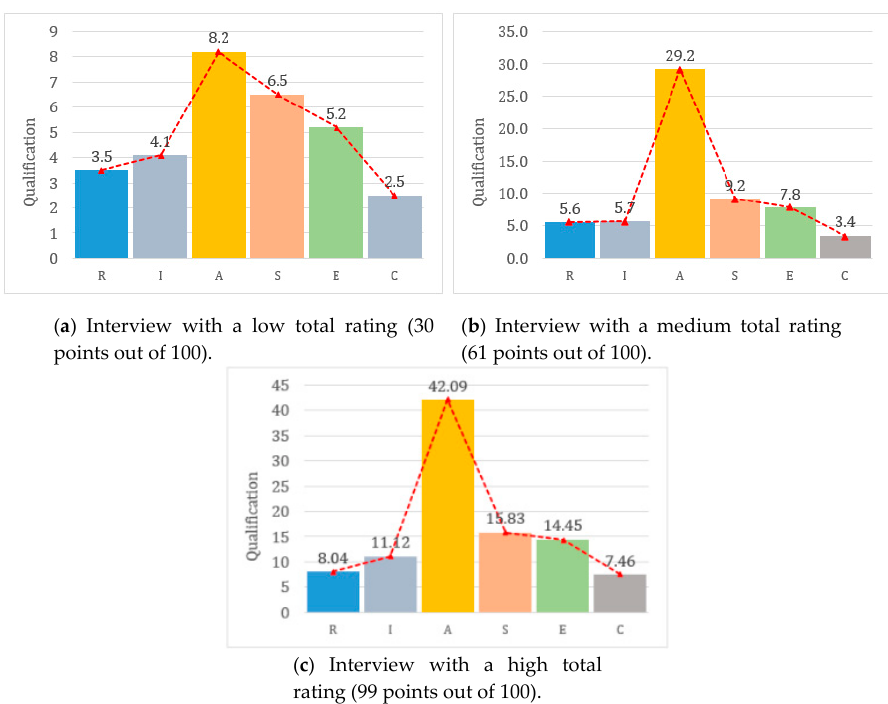
Figure 20. Graphical representation of the results obtained for vocational profile evaluation: Vocational Profile: ASEIRC.